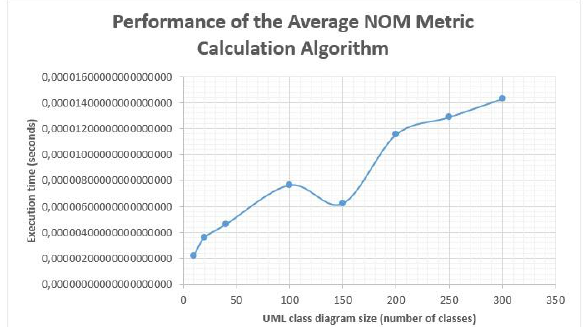
Fig. 9. Performance of the Average NOM Metric Calculation Algorithm